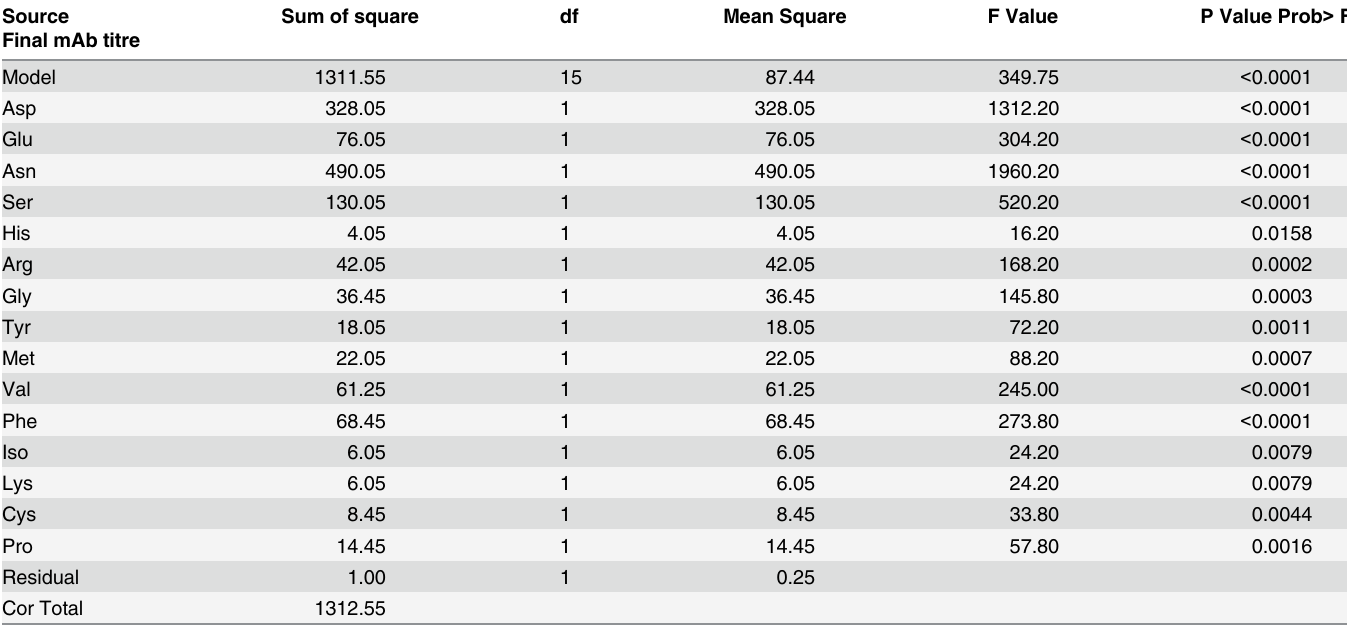
Table 5. ANOVA results for Plackett-Burman analysis for the final mAb titre response